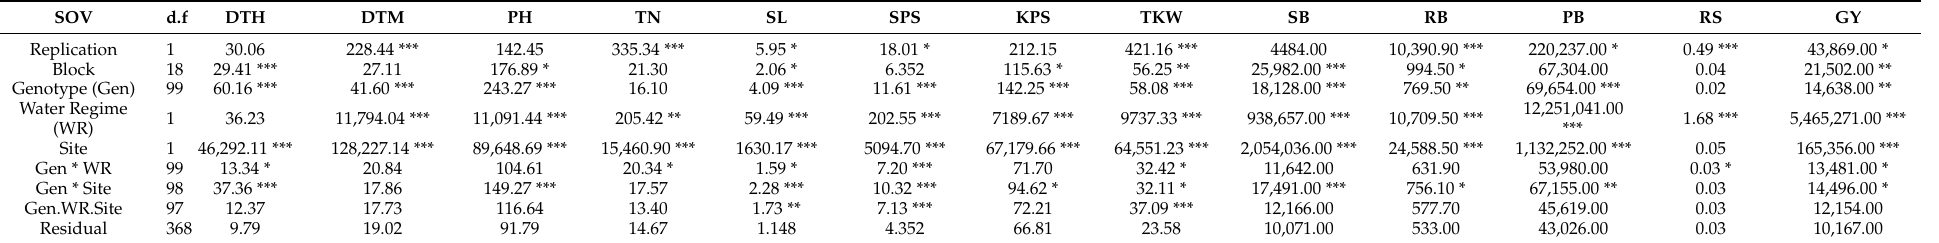
Table 1. Combined analysis of variance and significance tests for yield components and root attributes of 10 parental lines and their 90 F 2 progenies evaluated under drought-stressed and non-stressed conditions across two sites.